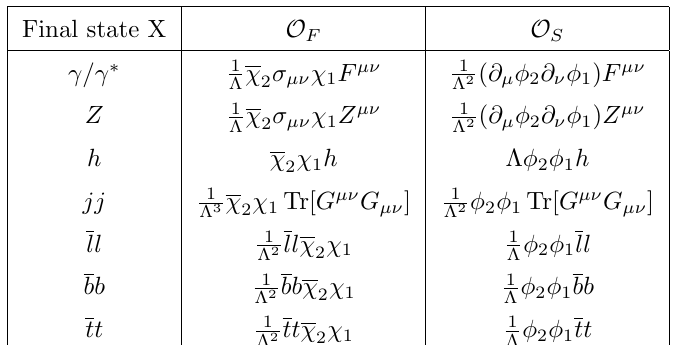
Table 2 . List of example e(cid:11)ective operators for the decay (cid:31) and scalar (right column) DM particles. Each of these operators corresponds to di(cid:11)erent (cid:12)nal state X (left column). Note that this is not an exhaustive list. For example, one could also have diboson (cid:12)nal states. Furthermore, the scalar charge radius operator gives decays only to o(cid:11)-shell photons, (cid:13) (cid:3) ff; W + W (cid:0) !